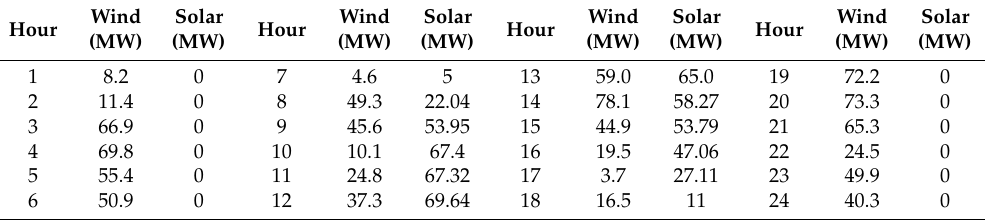
Table 4. Wind–solar